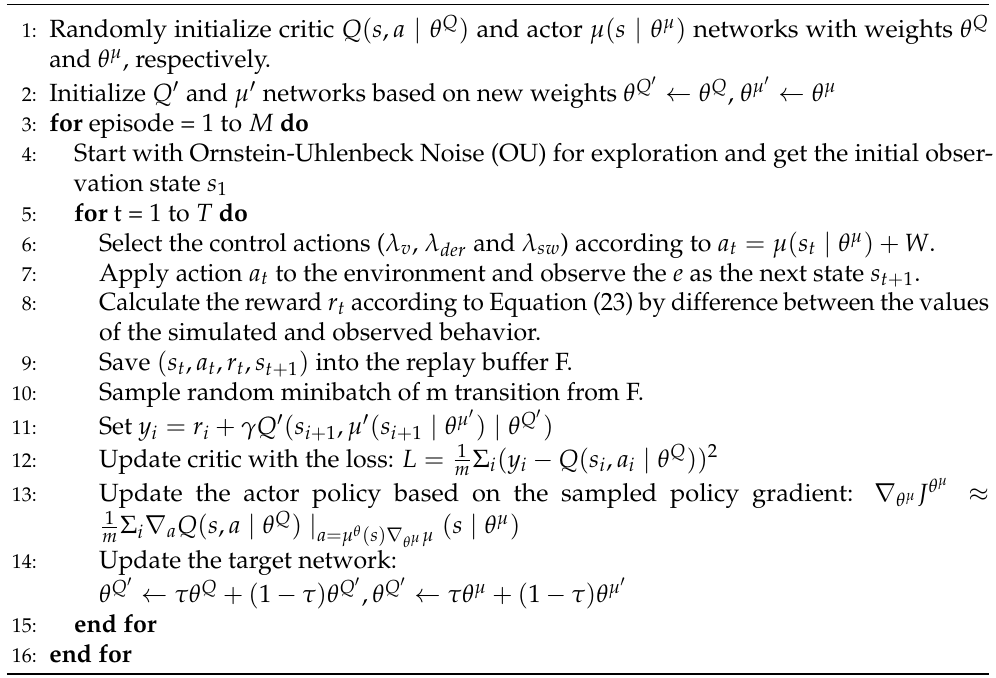
Figure 5. Flowchart of the proposed multi-agent DRL based design of the weighting coefficients in the FCS-MPC. Algorithm 1 The pseudo-code for the standard